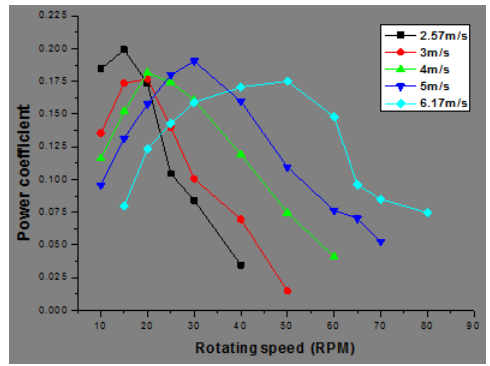
Figure 9. Power coefficient variation with inlet flow speed and rotat- ing speed.